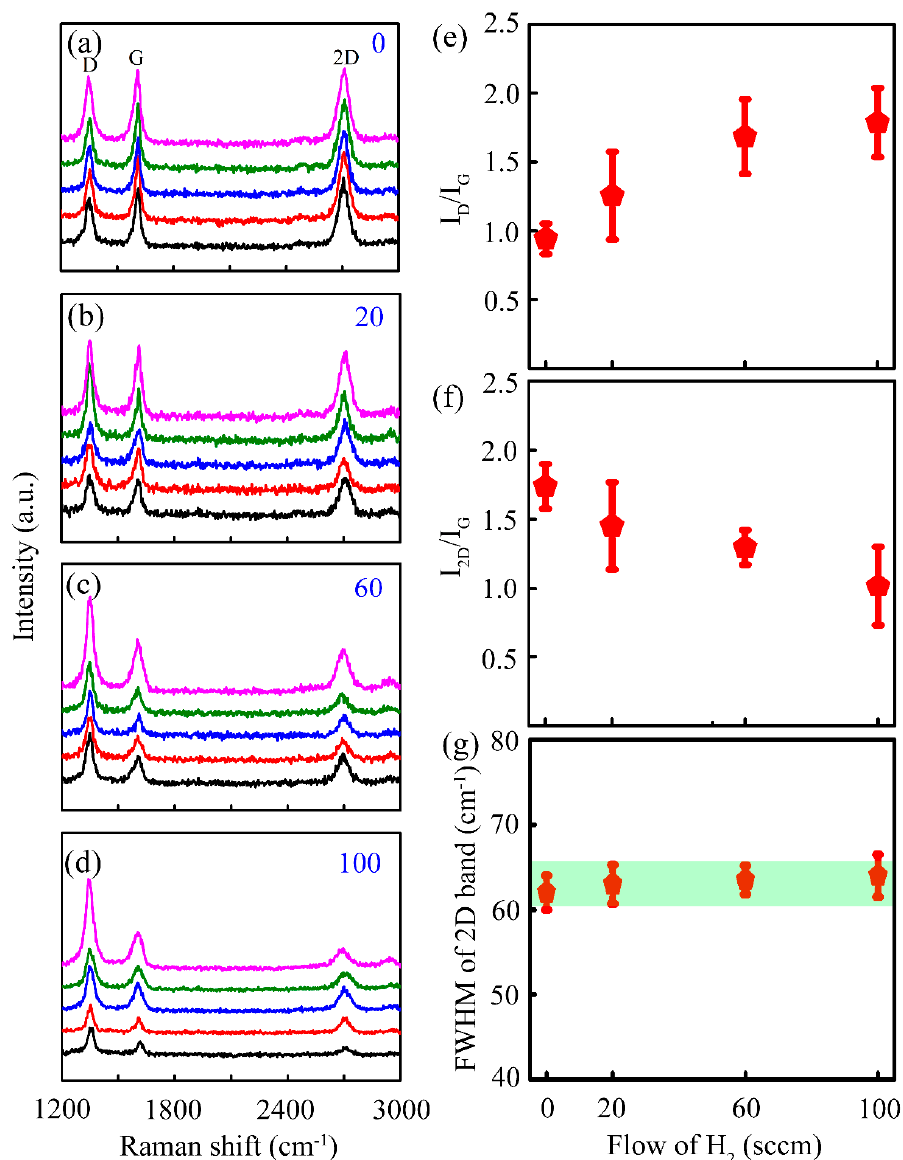
Figure 2. Effect of hydrogen on the properties of the as-grown graphene. Raman spectra of the graphene grown at H 2 doses of 0, 20, 60, and 100 sccm for ( a – d ), respectively. The five different colored curves represent Raman signal collected from five different points on each graphene. The details derived from ( a – d ), ( e ) I D / I G , ( f ) I 2D / I G , and ( g ) and full width at half maximum (FWHM) of the 2D band, respectively.